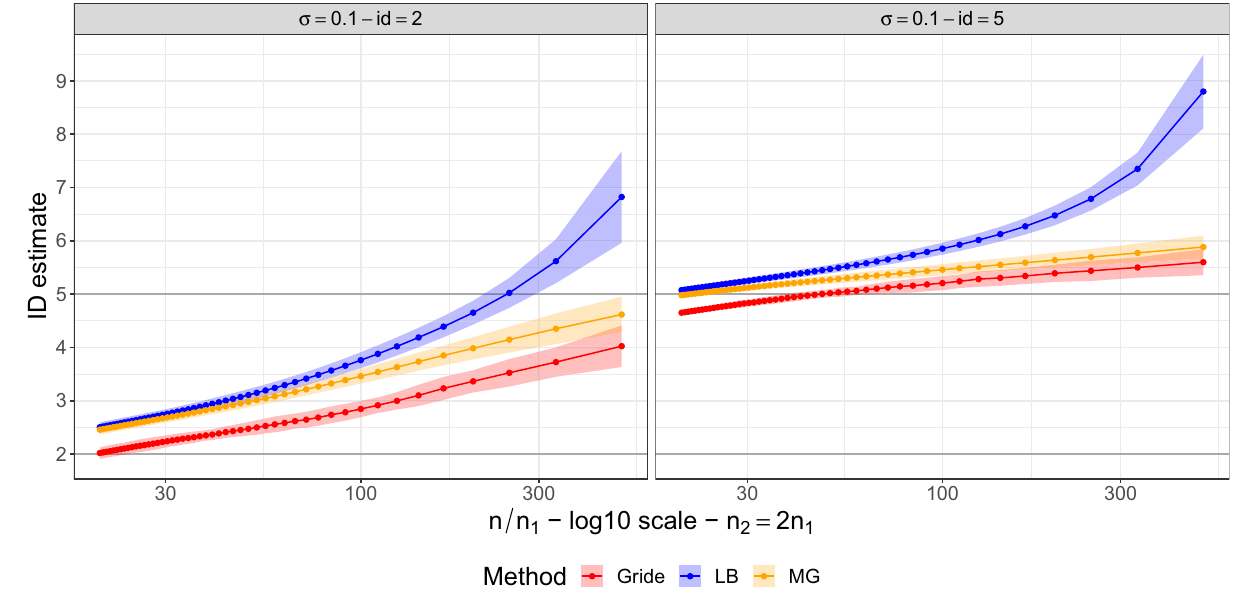
Figure 6. Each panel shows the average estimates of the id over 30 replicates with three different methods: 2 n 1 ), Gride (with n 2 = LB , and MG . Each dataset has 1000 observations. The confidence bands are drawn at ± 2 , in the right panel the true id is d standard errors. In the left panel the true id is d =